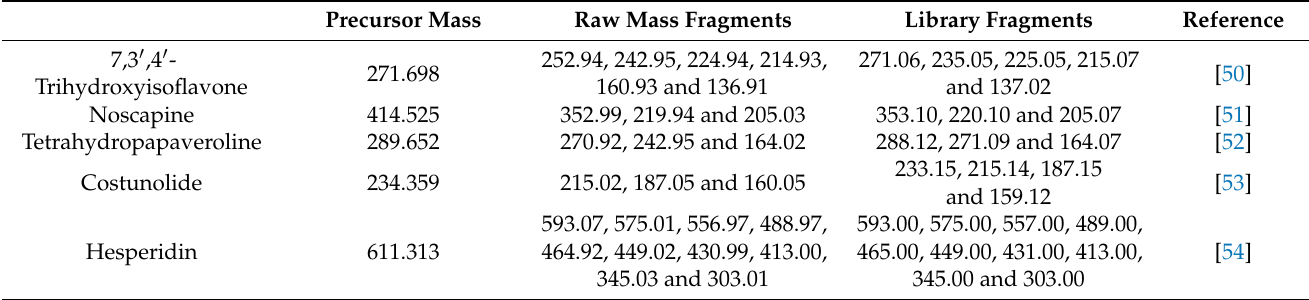
Table 1. The precursor and fragments’ masses of the identified metabolites compared with that of the standards from the molecular networking